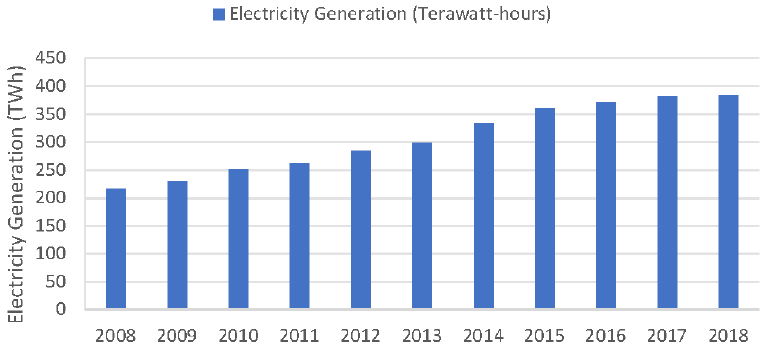
Figure 1. The growth of annual electricity generation between 2007 and 2017 (TWh) [5].